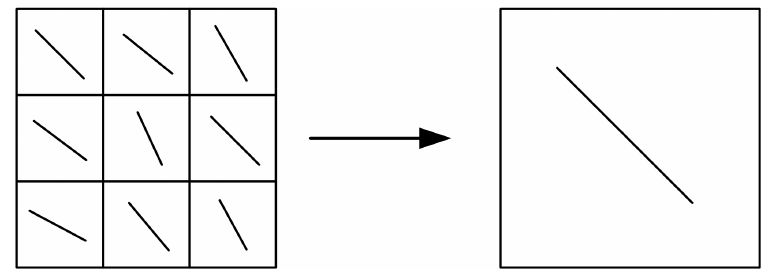
Figure 2. Process of MOT solving.